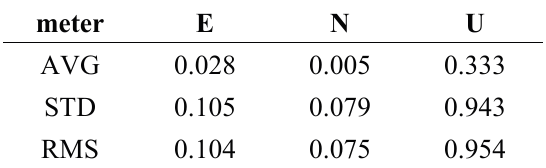
Figure 28. The positional errors of traditional photogrammetry based on ADIS 16488 with 300 m. Table 3. The statistical analysis of traditional photogrammetry based on ADIS 16488 with 300 m.